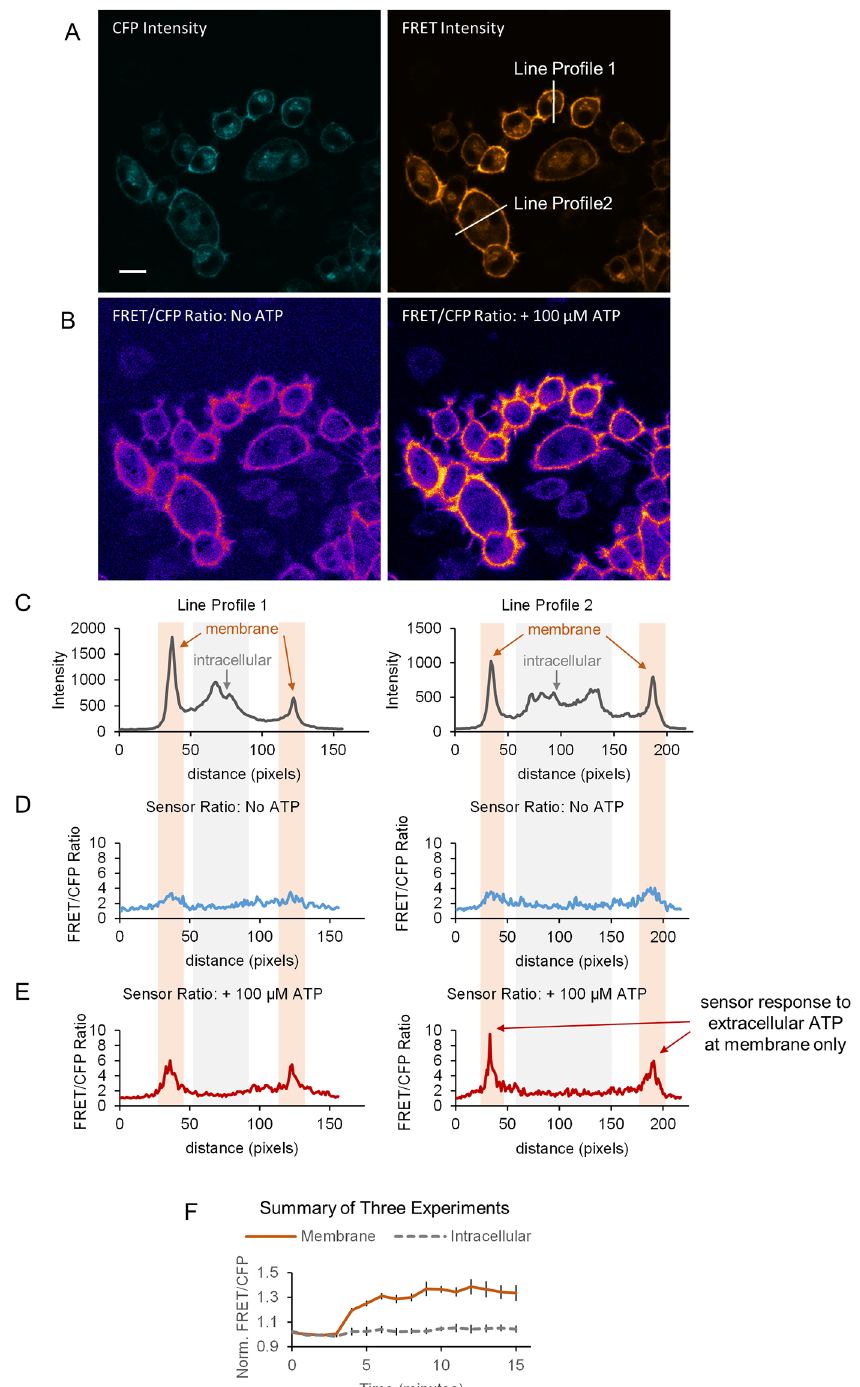
Fig 2. Surface-localized ecAT3.10responds to the addition of extracellular ATP. High magnification confocalmicroscopy demonstrates that the ecAT3.10 ratio signal responseto extracellular ATP occurs exclusively at the membrane. (A) Representative confocalfluorescence intensity images in the CFP and FRET channels show strong membrane localizedsignaland some intracellularpuncta. Scale bar is 20 μ m. (B) Pixel-by-pixelFRET/CFP ratio images before (left) and after additionof 100 μ M ATP (right) illustratesa responseat the membraneonly. (C-E) Line profile analysisfor the two examplecells shown in (A). A 5-pixel width line regionof interest was drawn through the membraneand peak areas of intracellular